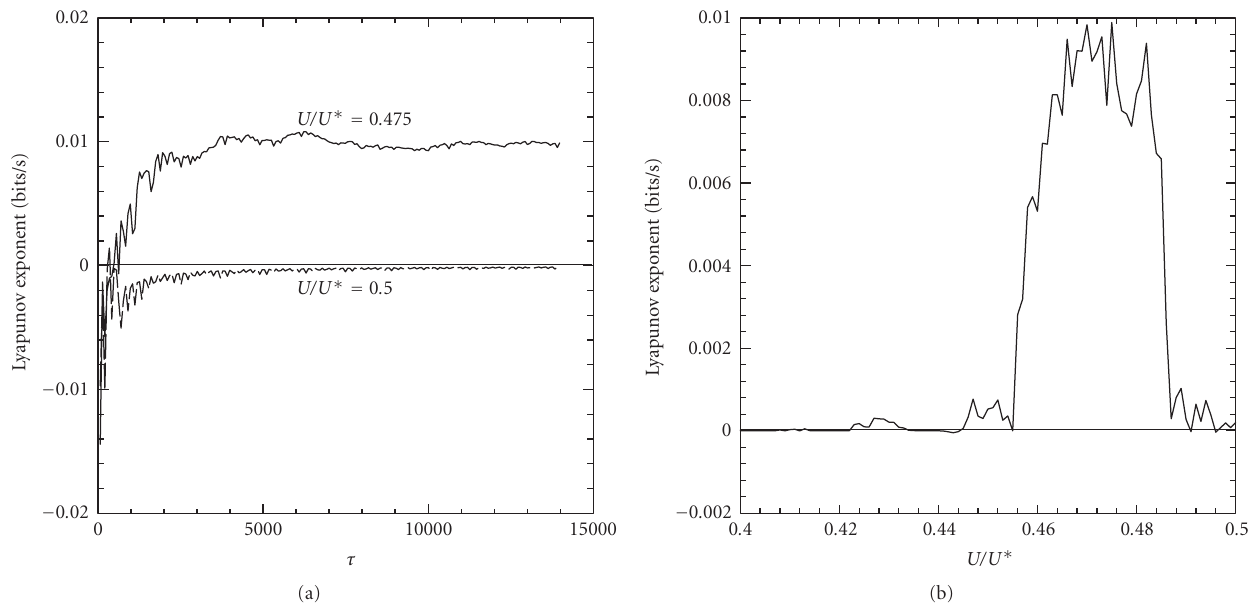
Figure 8: (a) Time evolution of the Largest Lyapunov exponents, (b) variation of the largest Lyapunov exponent with U/U ∗ for the same airfoil as Figure